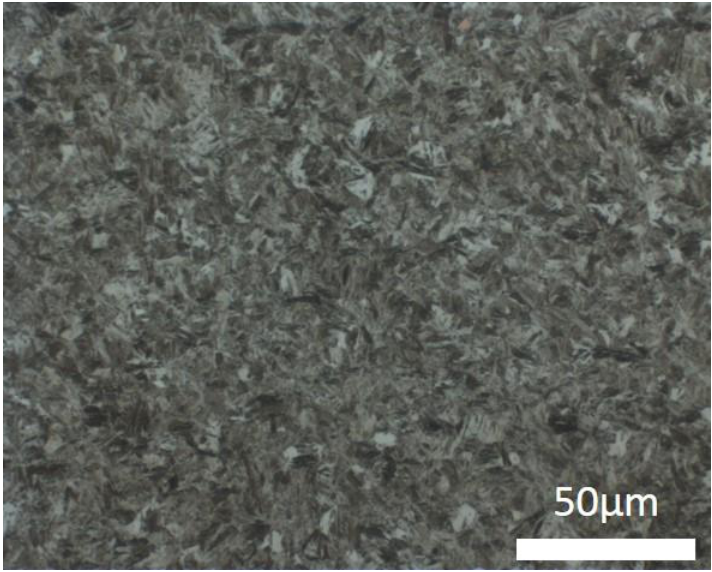
Figure 10. Martensitic microstructure of the material stamped at the 12.5 MPa set-point and analyzed in LP zone. Table 2. Vickers hardness measurement sampling for each pressure set-point. Average of five values and confidence interval of 95% of the mean.